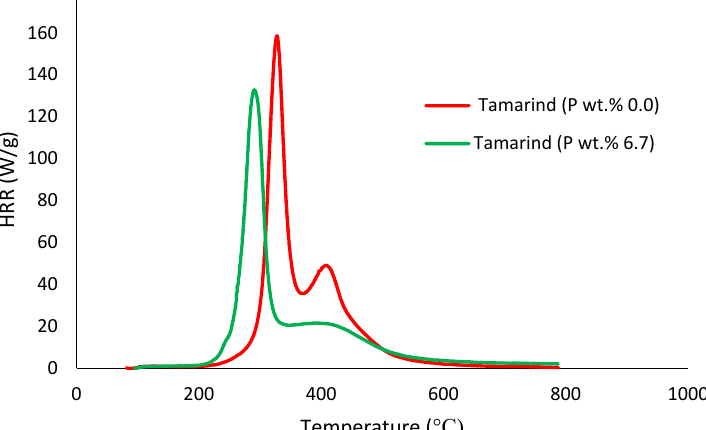
Figure 12. Plot of heat release rate (HRR) (W / g) versus temperature ( ◦ C) for modified and unmodified versions of tamarind. Table 3. Pyrolysis combustion flow calorimetry (PCFC) data for modified and unmodified versions of base substrates (average values of triplicate runs).